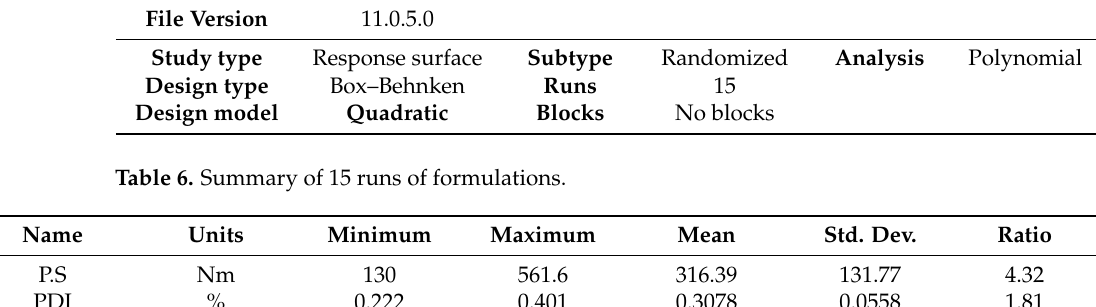
Figure 5. Three-dimensional graph showing effect of independent factors on response PDI (Y2). ( A ) effect of stirring speed and oil concentration on PDI. ( B ) effect of oil concentration and surfactant concentration on PDI. ( C ) effect of stirring speed and surfactant concentration on PDI.